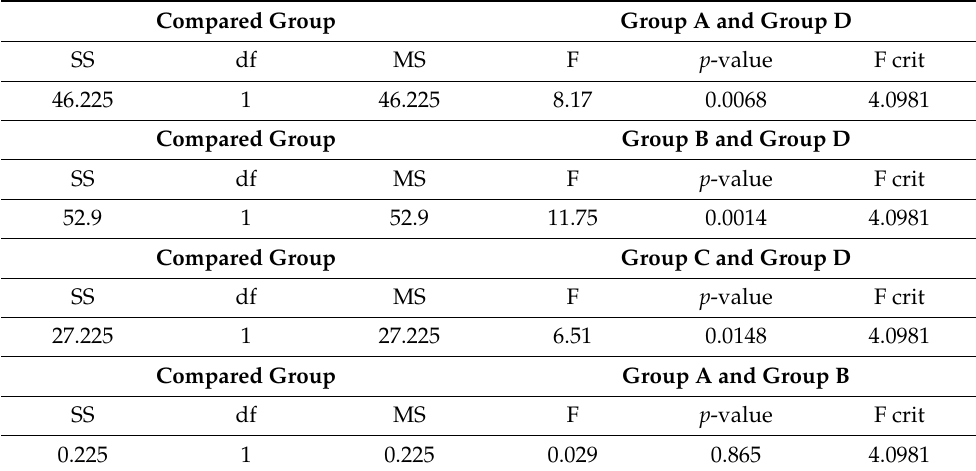
Figure 15. User Score Distribution. Table 4. One-way MANOVA Analysis Between Different Groups in Excel Software.